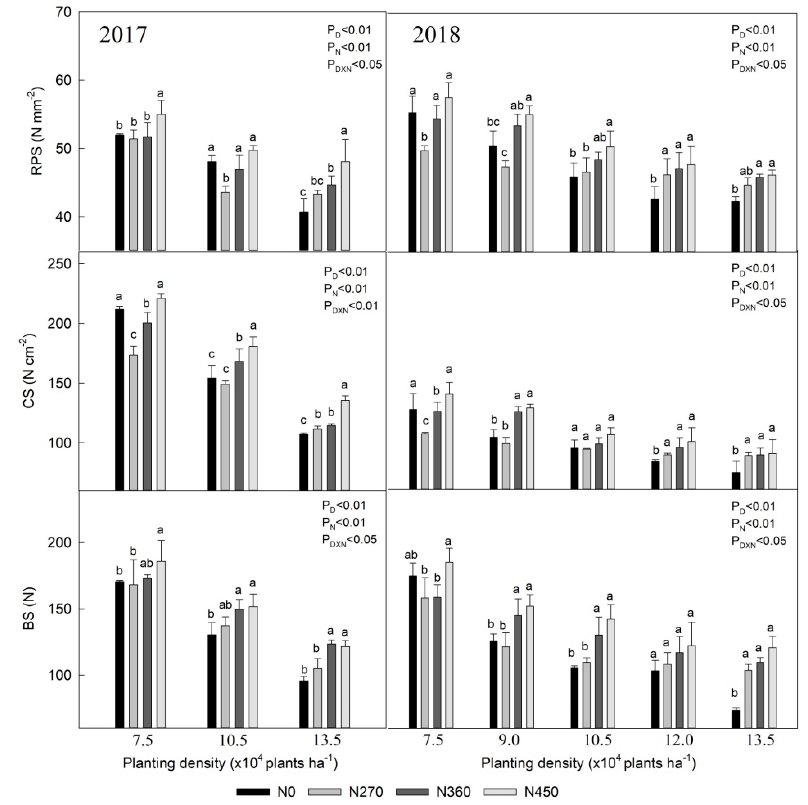
Figure 3. Effect of nitrogen application rate on the mechanical strength of maize stalks under drip irrigation at different planting densities. RPS: rind penetration strength; CS: crushing strength; BS: bending strength.